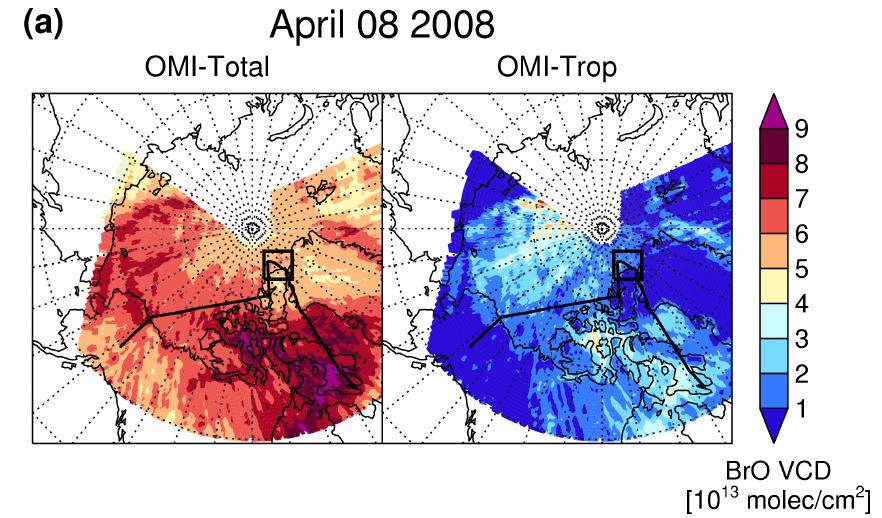
Fig. 8a. Similar to Fig. 6a but for the DC-8 flight on 8 April 2008. GOME-2 data are not available for this day. The location of severe ozone depletion and high active bromine sampled by the DC-8 is marked by the black squares.